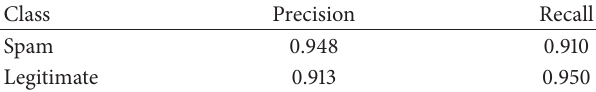
Figure 5: Triplets of RDF data model.